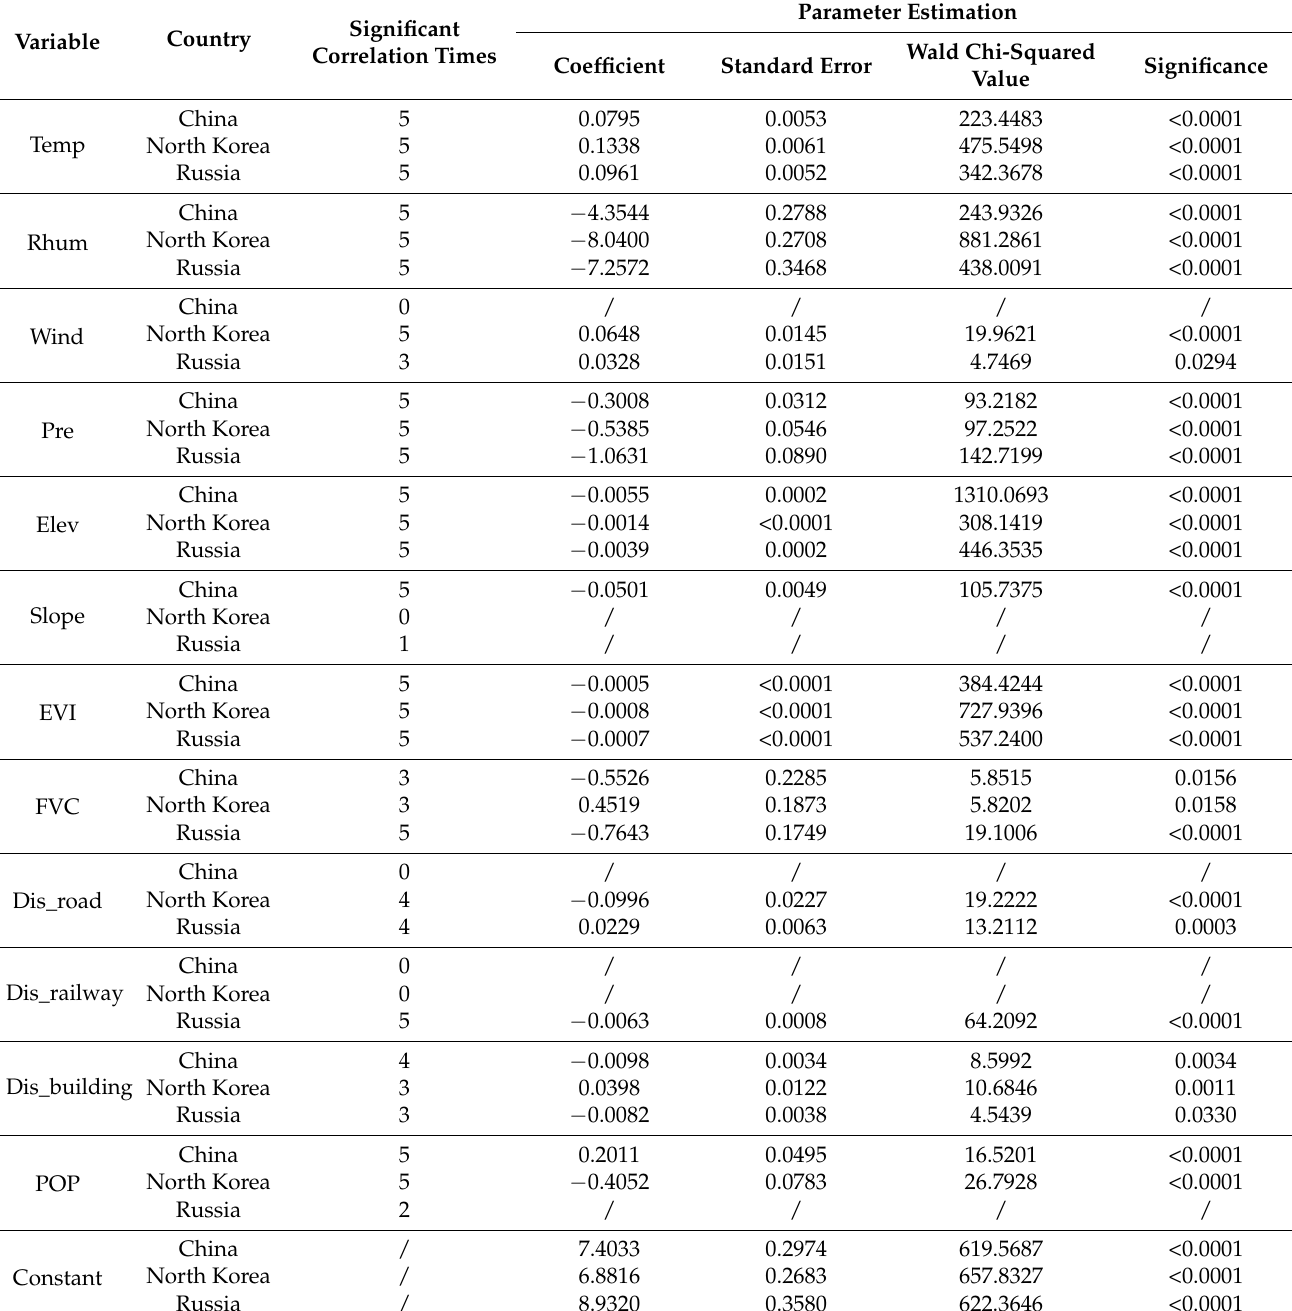
Table 4. The fitting results of the final model parameters of LR in different